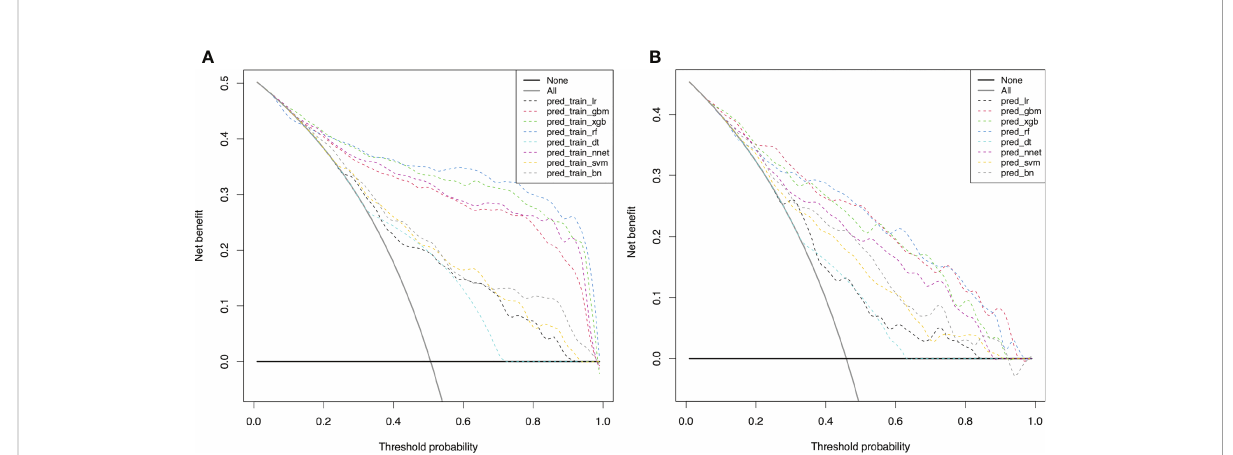
FIGURE 4 Decision curve for predictive models based on machine learning models for prediction of CLNM. (A) The decision curve in the training cohort; (B) The decision curve in the validation cohort. CLNM , Central lymph node metastasis; LR , Logistic Regression; GBM , Gradient Boosting Machine; XGB , Extreme Gradient Boosting; RF , Random Forest; DT , Decision Tree; NNET , Neural Network; SVM , Support Vector Machine; BN , Bayesian Network.